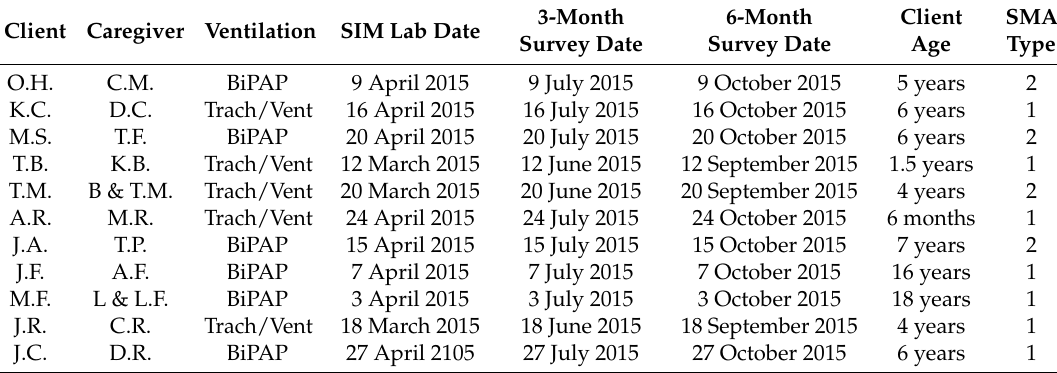
Table 1. Demographics of sample children ( n = 11) with spinal muscular atrophy (SMA). Client Caregiver Ventilation SIM Lab